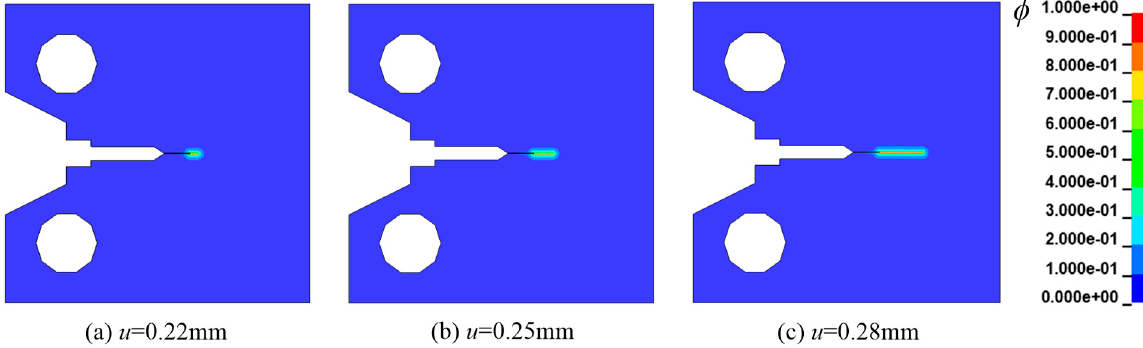
Figure 12. Crack growth process of CT specimen.